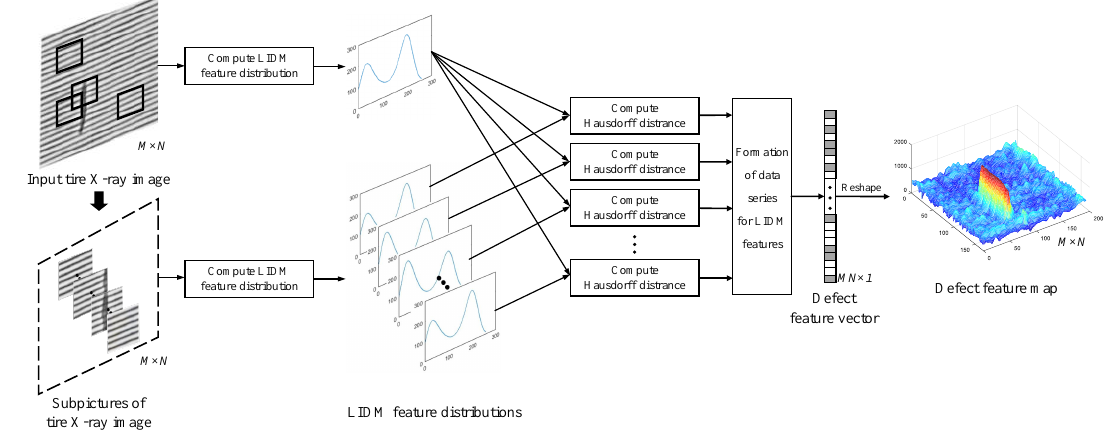
Figure 6. Construction of defect feature